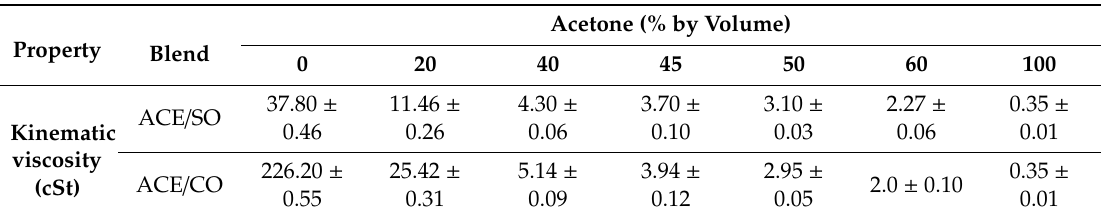
Table 1. Kinematic viscosity values at 40 ◦ C of acetone (ACE) / sunflower oil (SO) and ACE / castor oil (CO) double blends with di ff erent proportions of acetone; cSt, centistokes. Property